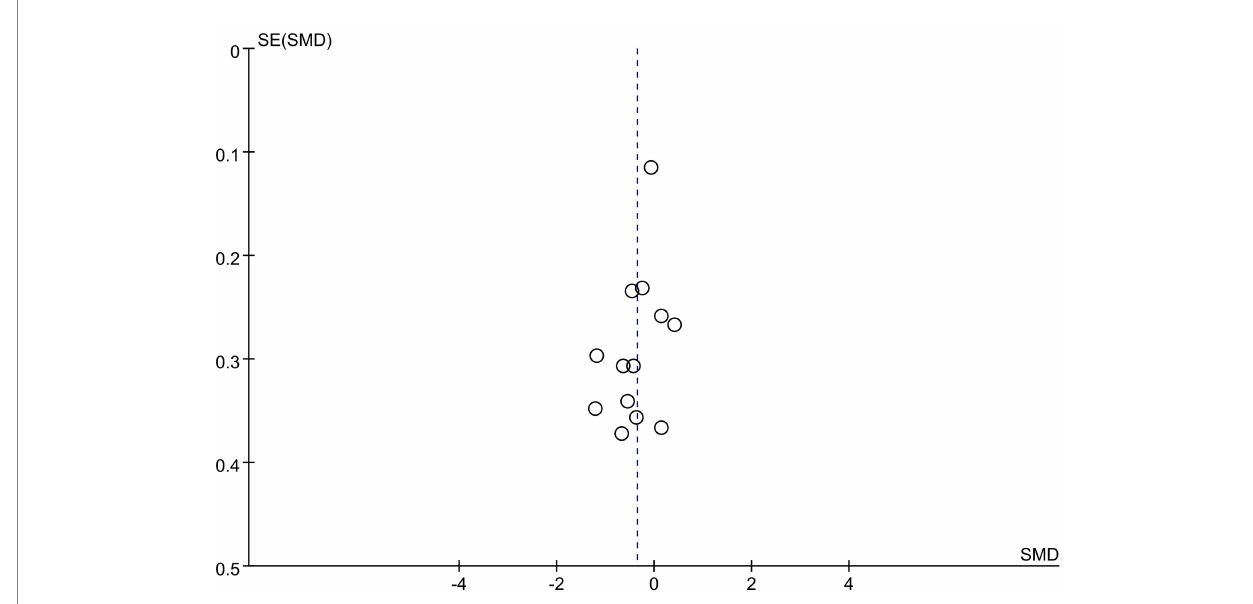
FIGURE 5 Funnel plot of depression outcome in comparison with ABM versus ACT.